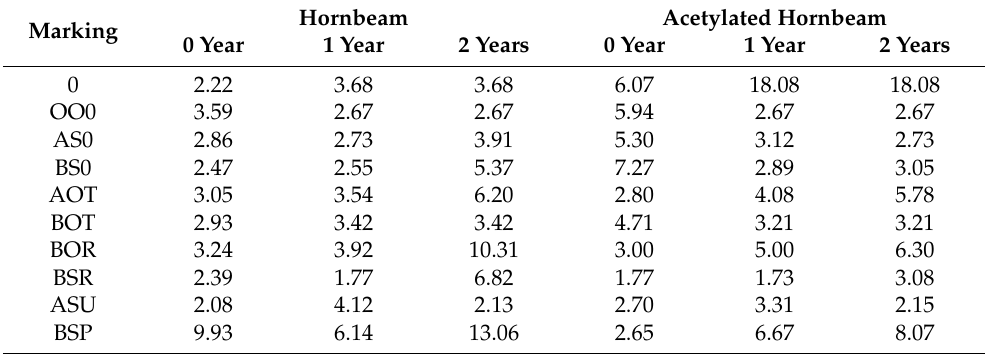
Table 6. Color variation of weather-exposed hornbeam (color difference compared to average color). Average values of 20 measurements are presented.